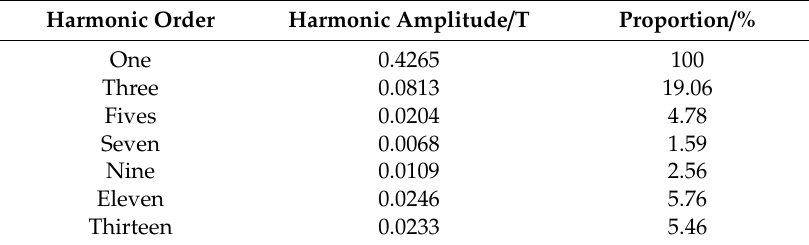
Table 2. Magnitude of each harmonic and its proportion in the fundamental. Harmonic Order